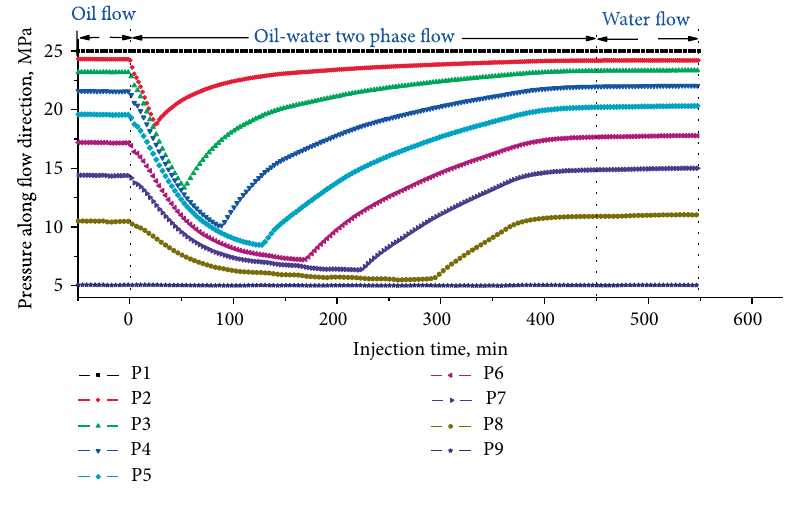
Figure 10: The water flooding results in tight oil reservoirs.